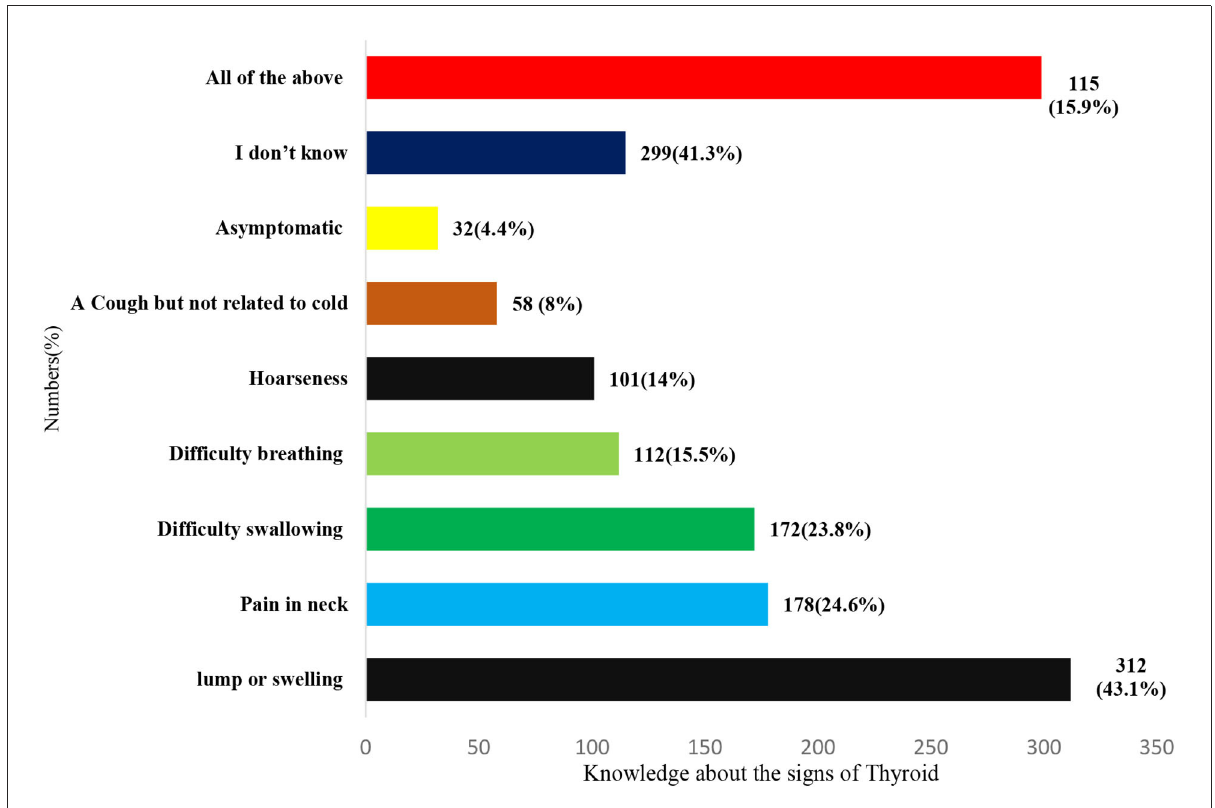
FIGURE1 Knowledge about early signs of thyroid